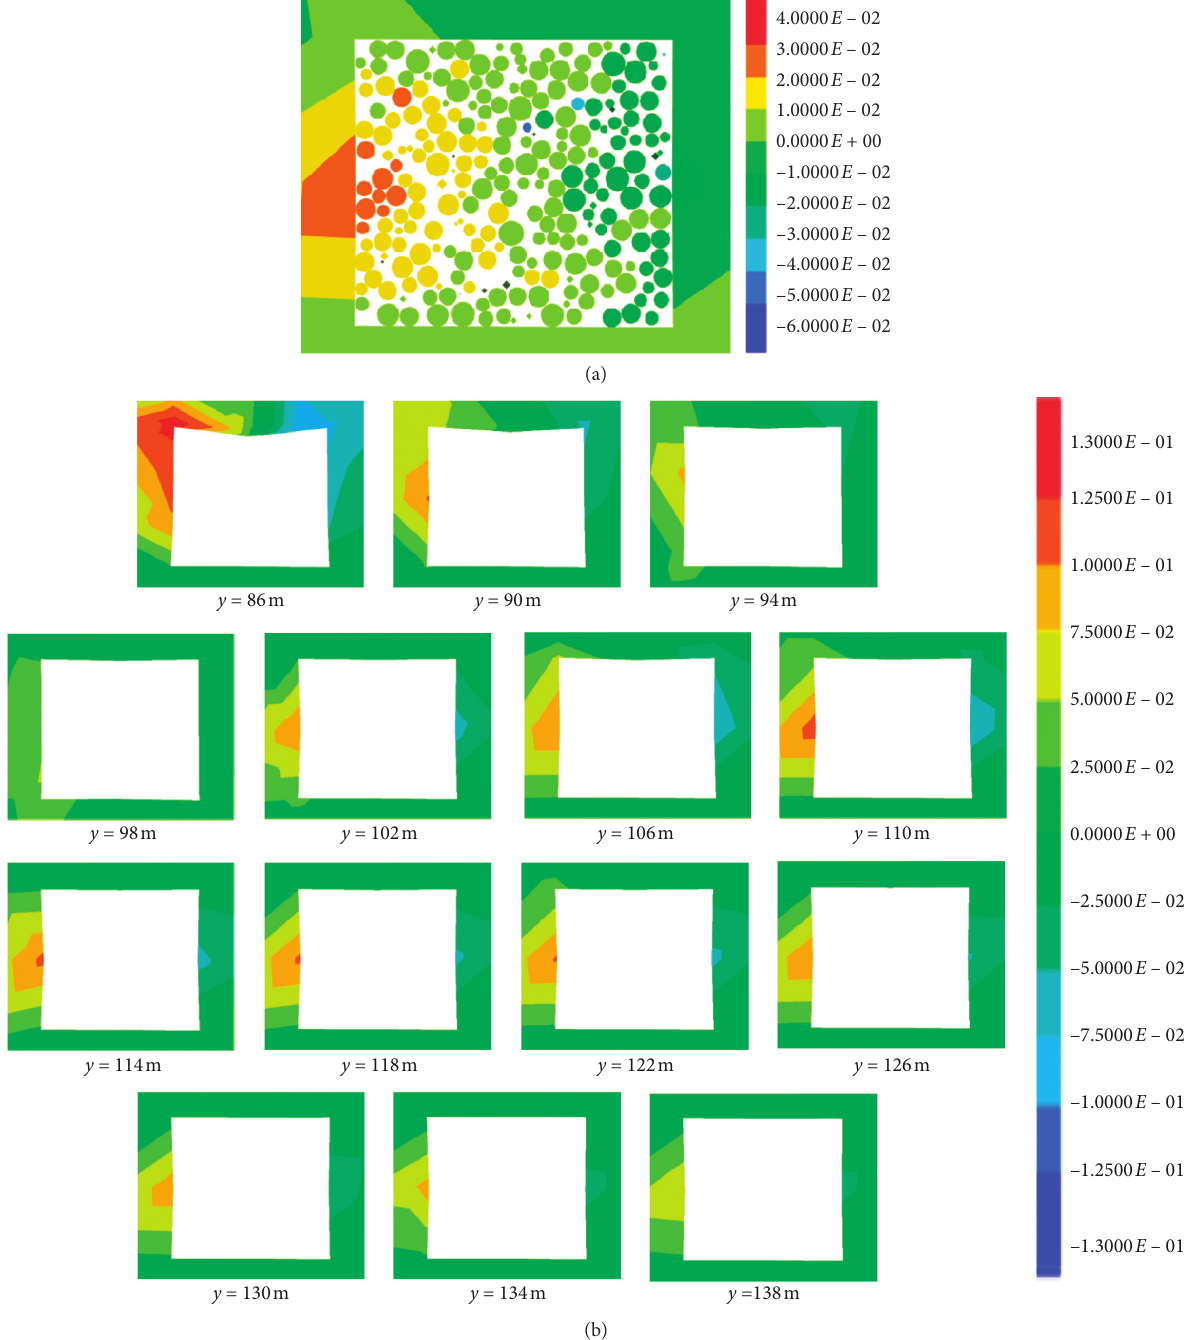
Figure 11: x -displacement of the cross-cut walls in SAR section. (a) Maximum x -displacement of the cross-cut walls after backfilling in measure point y � 126m. (b) x -displacement of the cross-cut walls without